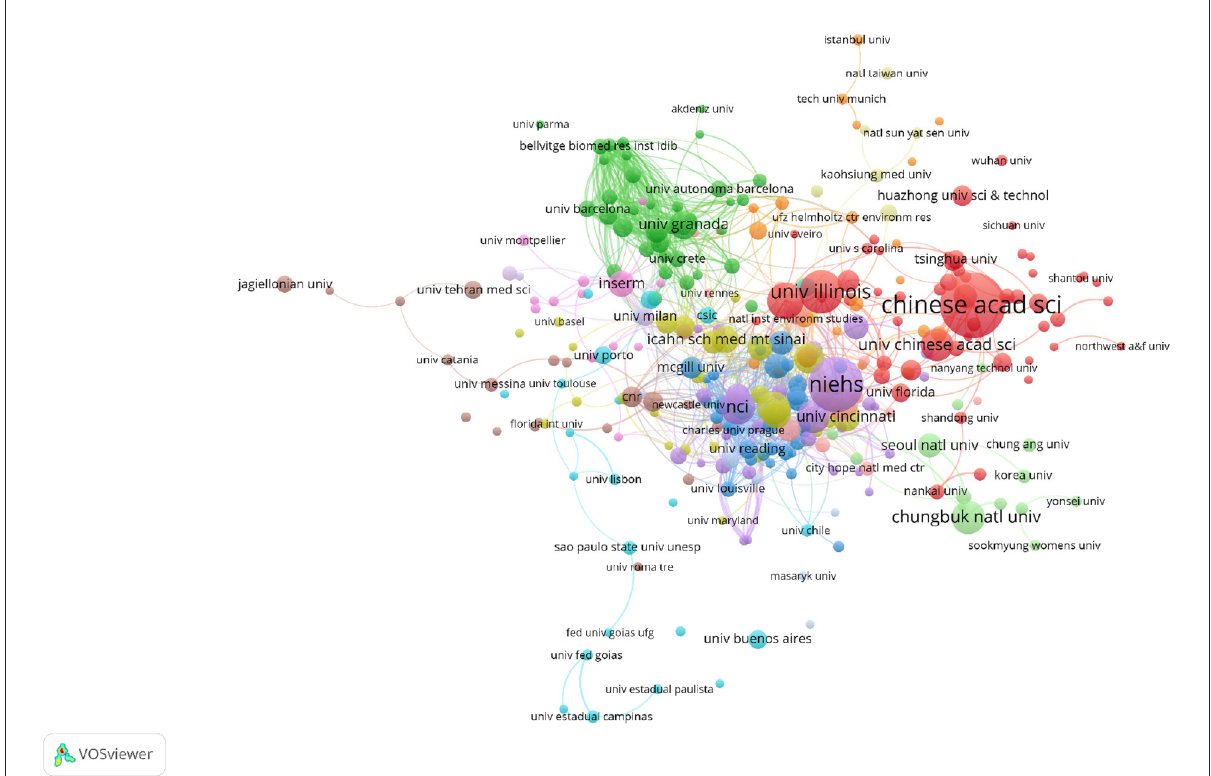
FIGURE5 The network visualization map of co-authorship between organizations with more than five publications.